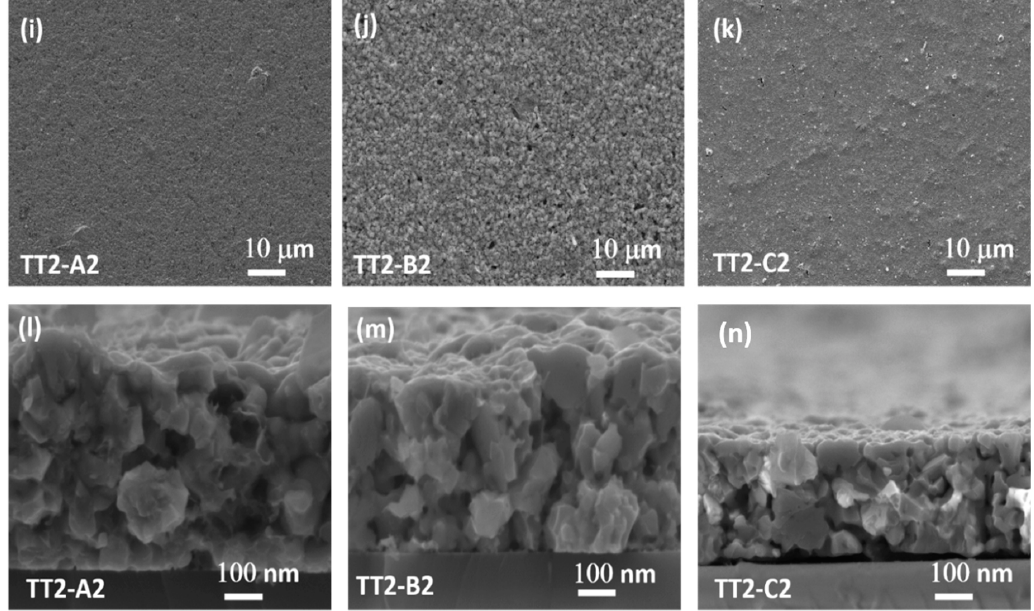
Figure 4. SEM image of CZTS nanocrystals after soft annealing (TT0) ( a : planer, b : cross-section) TT1 ( c – e : planar, f – h : cross section), TT2 ( i – k : planar, l – n : cross section).